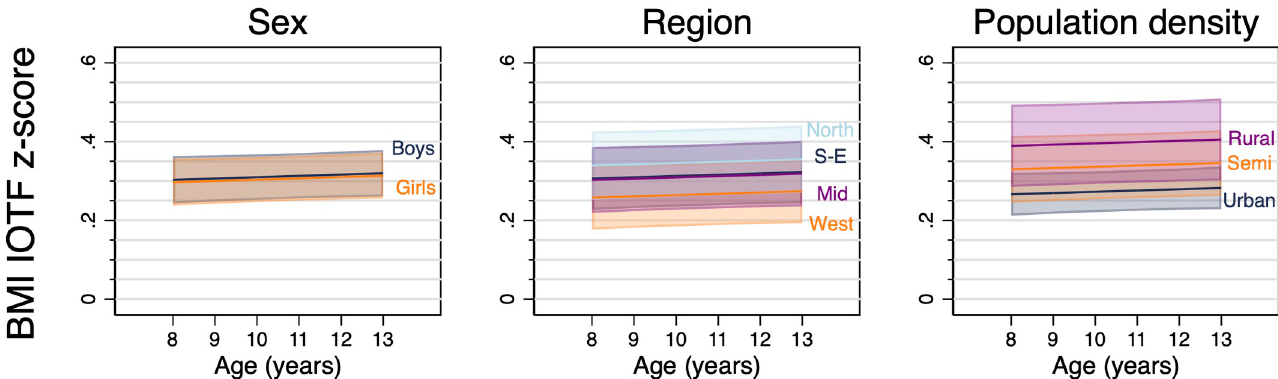
Fig 3. Marginal predicted � mean BMI IOTF z-score † by sex (left), region (middle) and population density (right). BMI: Body mass index; IOTF, International Obesity Task Force; S-E: South-East; Semi: Semi-urban. � Marginal estimates predicted from the random effect regression models, n = 1852, 3317 observations = 3317. The shaded area is the 95% confidence interval. † IOTF z-score: Age- and sex-specific standardized z-score calculated from the IOTF LMS parameters.